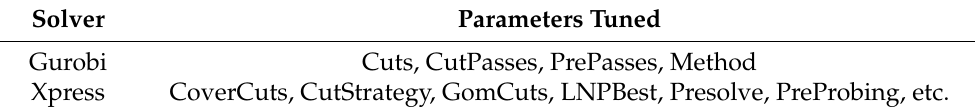
Table 2. Solver tuning.